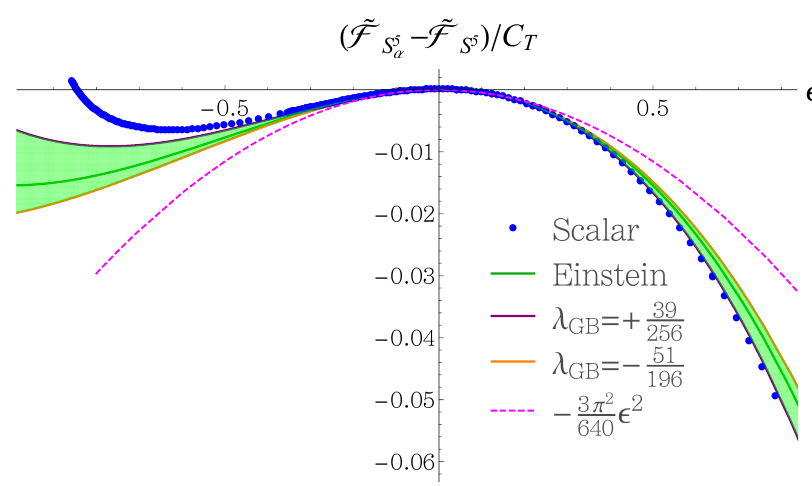
Figure 6 . The same quantity as in (cid:12)gure 5 as a function of (cid:15) . We have also included the leading universal quadratic term (dashed pink